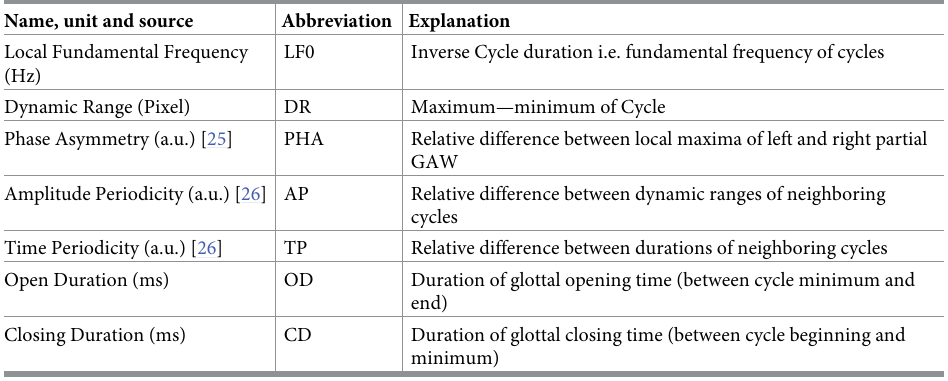
Table 2. Name, source, unit, abbreviation and a short explanation of all calculated